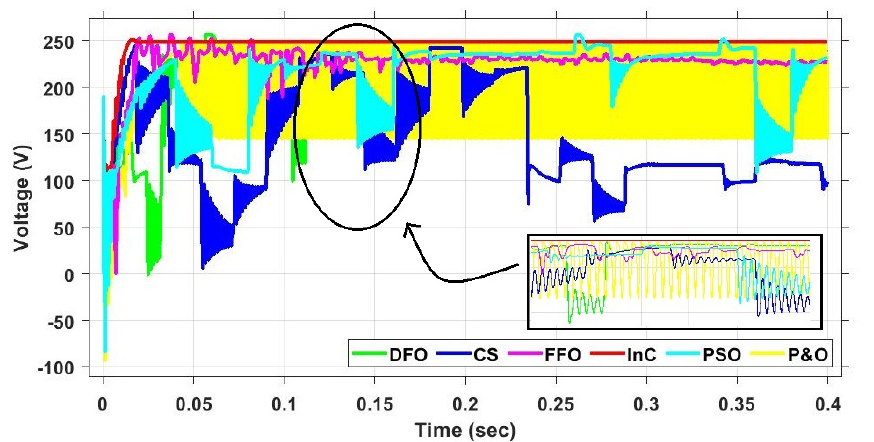
Figure 21. PS3 voltage comparison between all algorithms for centralized PV